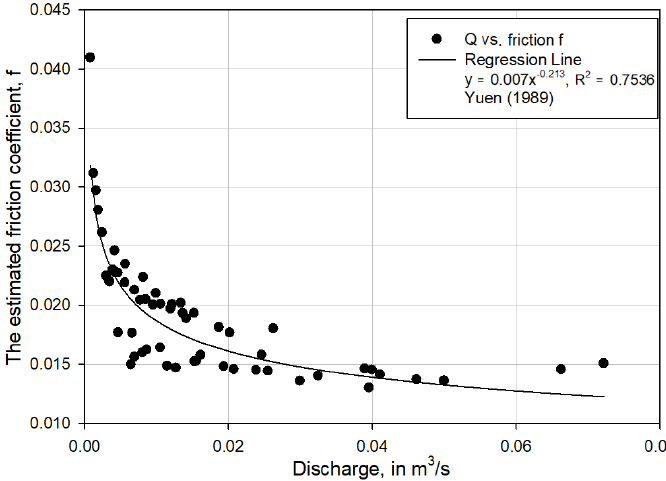
Figure 6. The relationship of f and Re calculated using Babaeyan-Koopaei’s data.